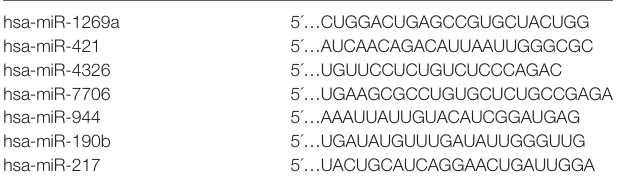
TABLE 1 | Sequence of each miRNA.